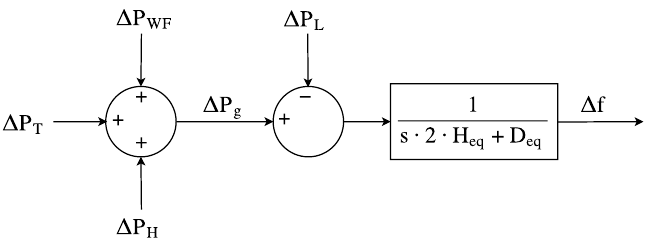
Figure 11. Simplified diagram of the modeled power system